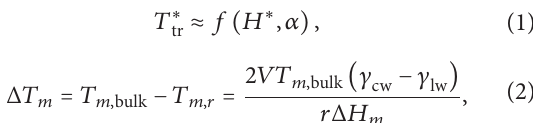
-C system con�ned experimental melting points at mole frac- 11 12 ○